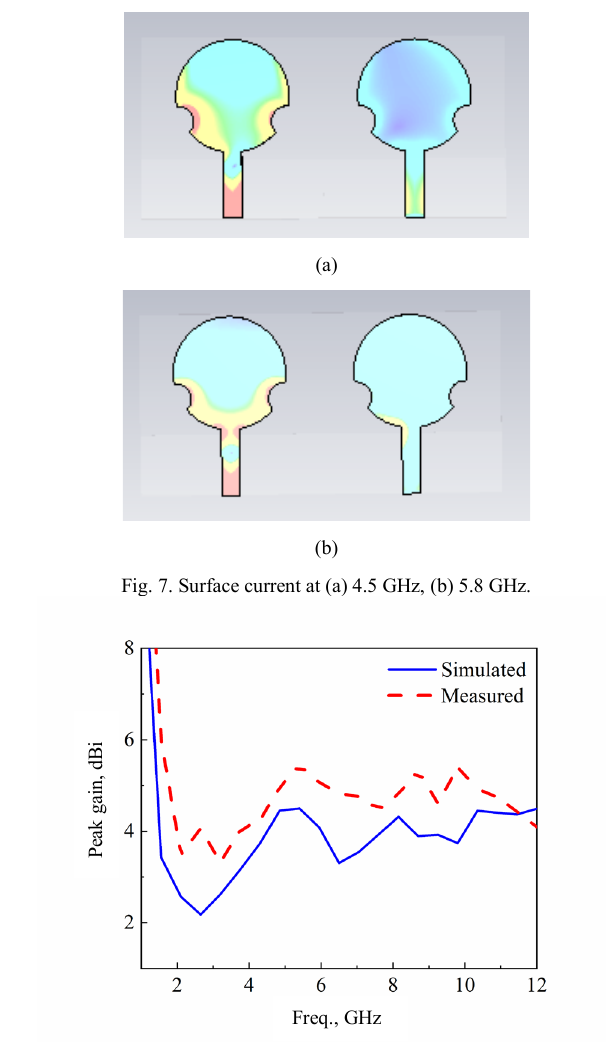
Fig. 8. Measured and simulated peak gain.